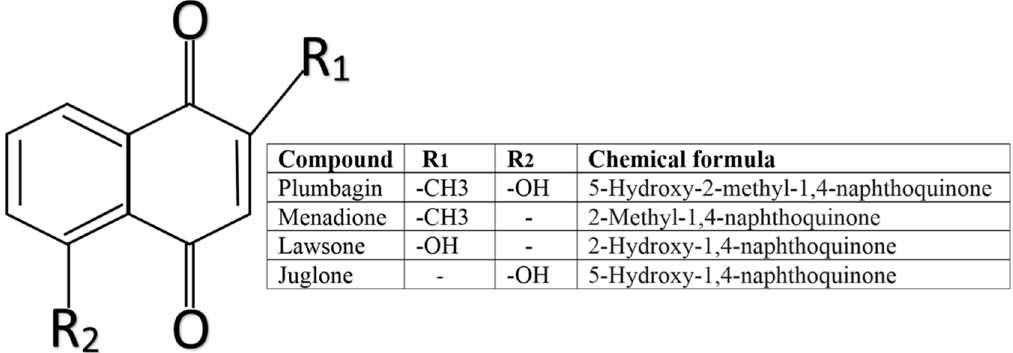
Figure 1. Structural formula of 1,4-naphthoquinones.